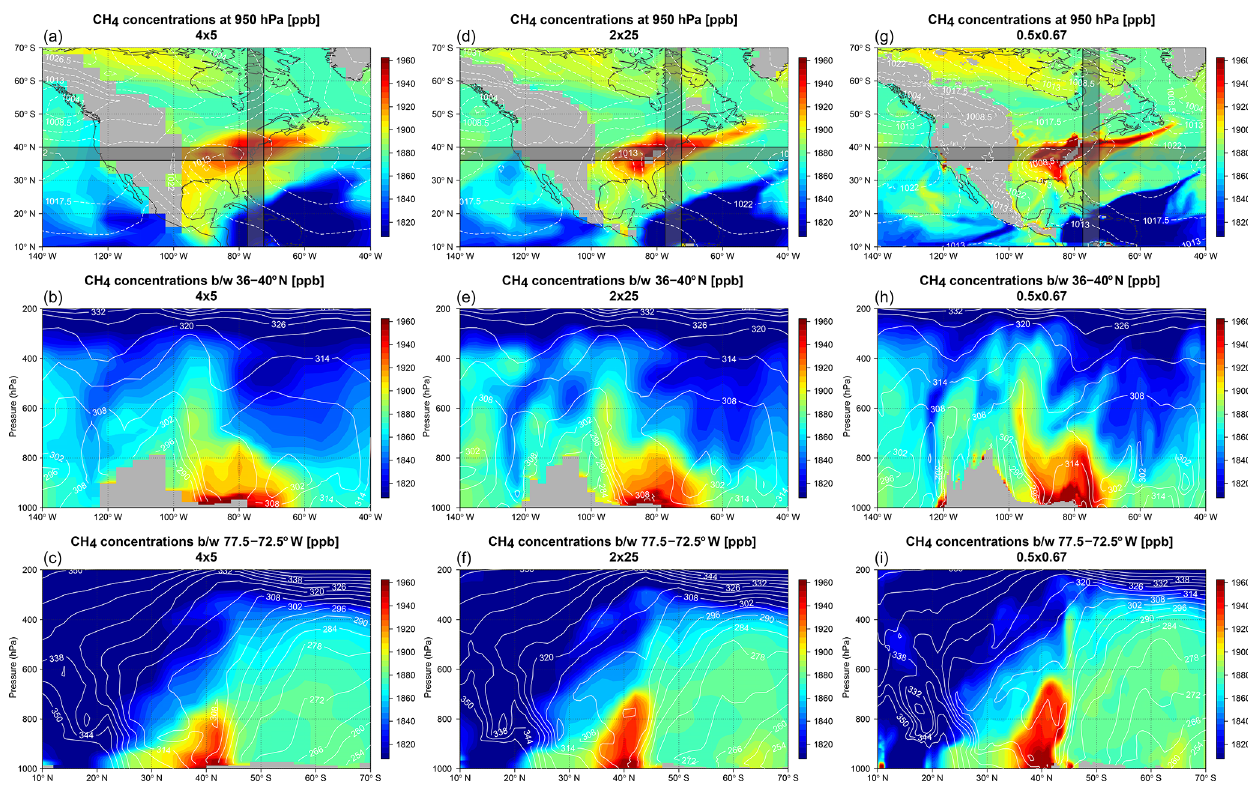
Figure 12. The distribution of CH 4 in GEOS-Chem at 12:00UTC on 21 March 2010 at 4 ◦ × 5 ◦ (a, b, c) , 2 ◦ × 2 . 5 ◦ (d, e, f) , and 0 . 5 ◦ × 0 . 67 ◦ (g, h, i) . Top row: the distribution at 950hPa, with sea level pressure indicated by the long dashed white lines. Middle row: altitude–longitude cross section along the grey horizontal band in the figure in the top row. Bottom row: altitude–latitude cross section along the grey vertical band in the figure in the top row. The solid white lines in the figures in the middle and bottom rows indicate the moist